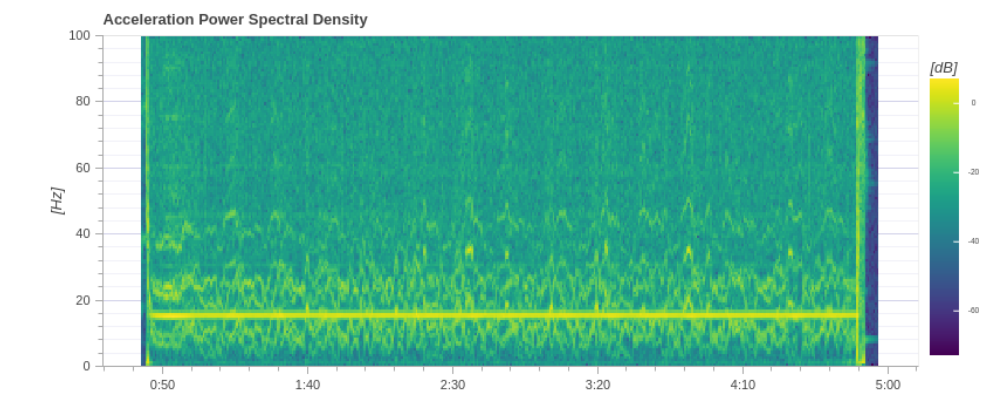
Figure 11. Spectrum for the second-generation tensegrity drone collected via PX4 log collector and plotted using PX4 Flight